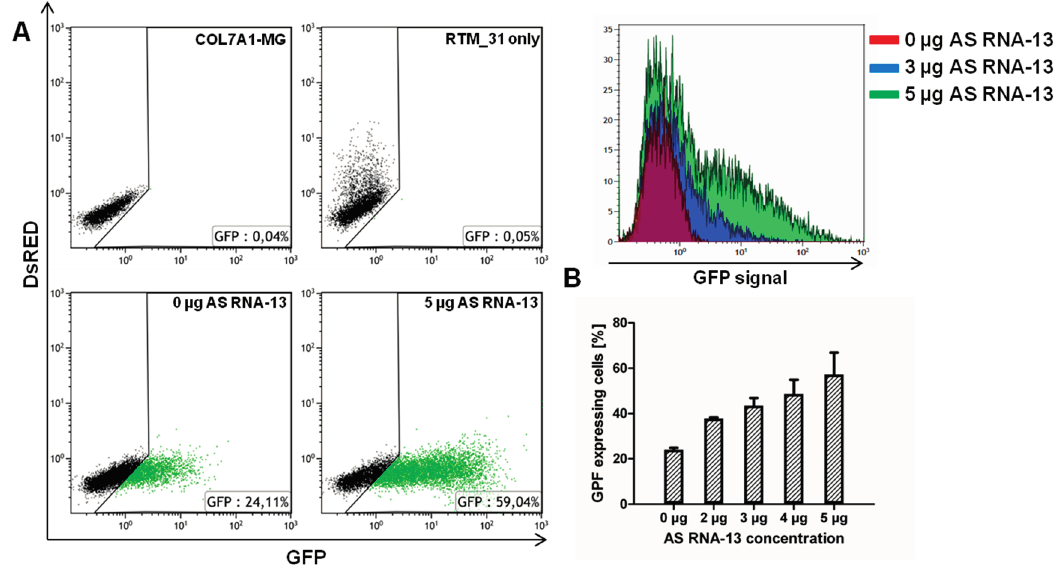
Figure 3. Increasing amounts of AS RNA-13 enhance GFP expression in a triple-transfection assay. After transfection of increasing amounts (0, 2, 3, 4 and 5 µg) of AS RNA-13 into HEK293 cells, co-transfected with 1 µg RTM_31 and 1 µg COL7A1 -MG, the GFP-expressing cell population increased with the amount of AS RNA-13 introduced. ( A ) Dot blots showed increased GFP expression (green dots) in cells treated with 5 µg AS RNA-13 in comparison to the cell population exclusively transfected with RTM and COL7A1 -MG-expressing plasmids; and ( B ) The increase of GFP expression correlates with the amount of AS RNA-13 (0 µg, 2–5 µg) transfected into HEK293 cells (the mean value + SD of two